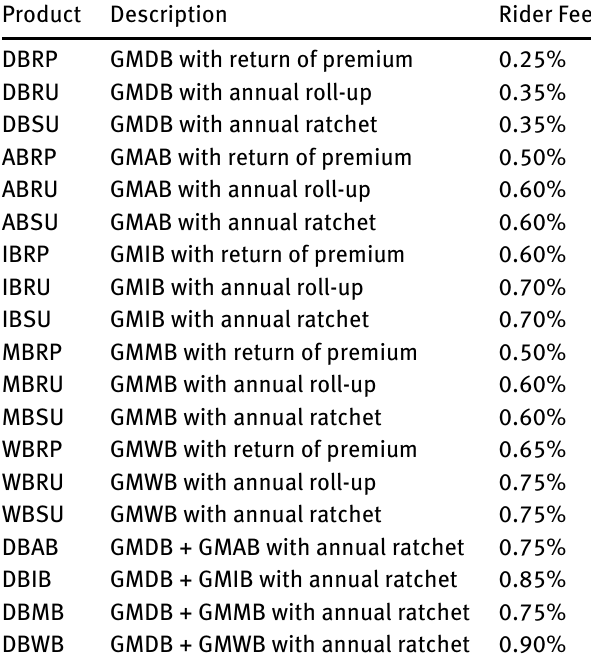
Table 1: Variable annuity contracts in the synthetic